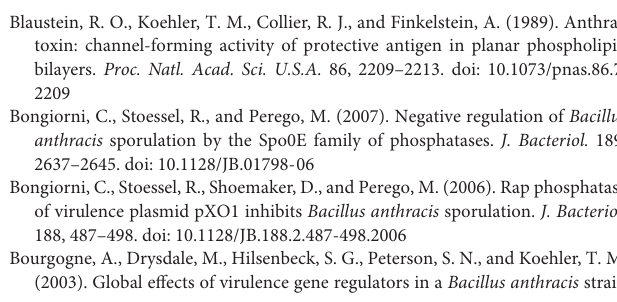
FIGURE S1 | The atxA -up sporulation defect is atxA -dependent. FIGURE S2 | Introduction of skiA results in decreased sporulation. Heat-resistant CFU/ml of skiA and atxA mutant strain derivatives cultured in (A) PA-air, (B) CACO 3 +5% CO 2